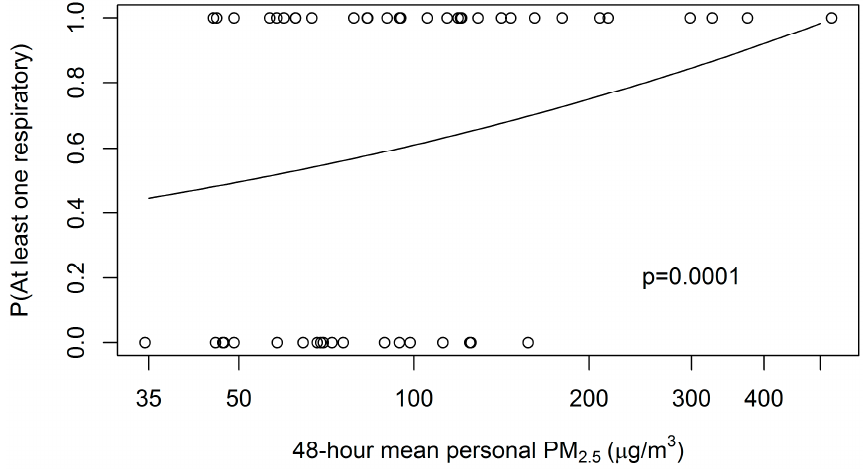
Figure 1. Fitted log-binomial-model probability of any respiratory condition for the primary cook, on 48-h mean personal PM 2.5 concentration, controlled for age. Plotted points are respiratory condition (0 = none, 1 = any of four).